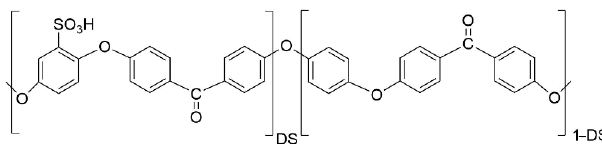
Figure 1. Structural formula of